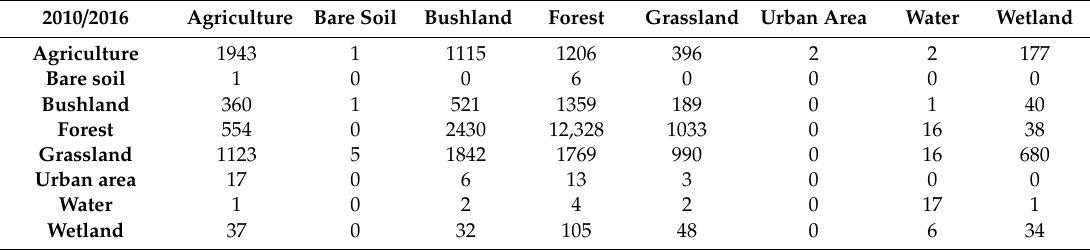
Table 6. Transition matrix of land use in the Kilombero Valley floodplain from 2010 to 2016 (km 2 ). 2010 / 2016 Agriculture Bare Soil Bushland Forest Grassland Urban Area